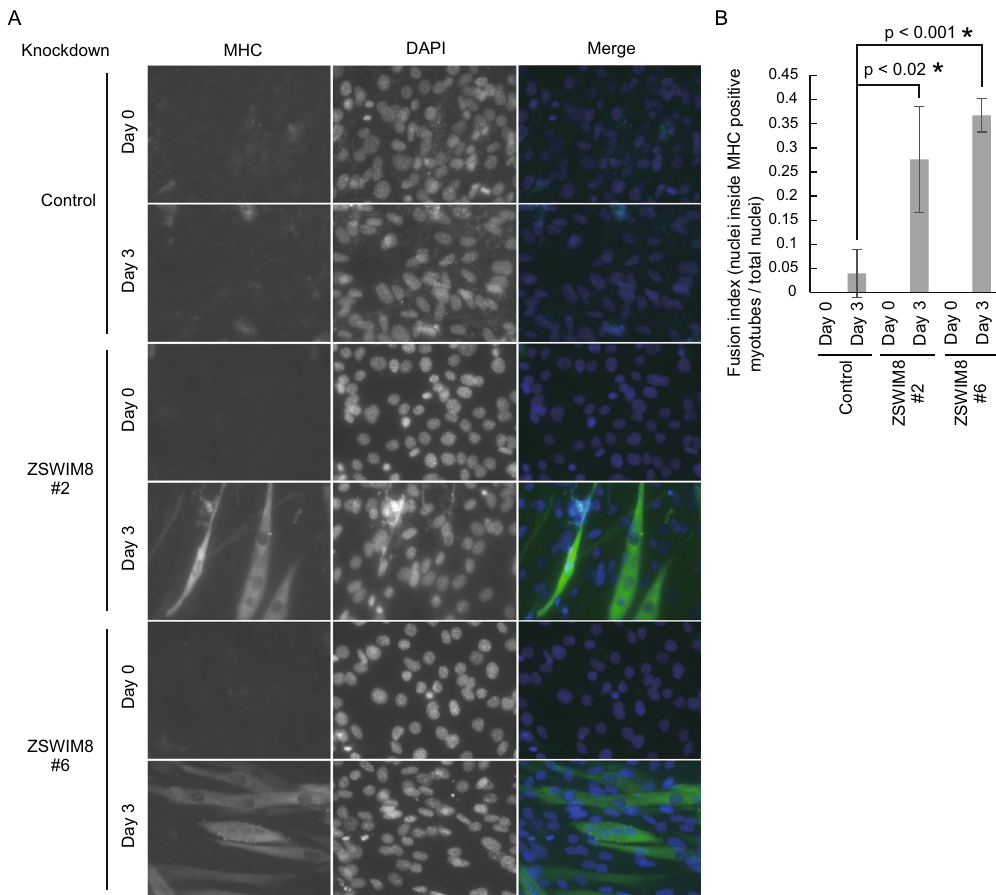
Figure 2. Accelerated myotube formation with ZSWIM8 knockdown. ( A ) Growing (day 0) or differentiated (day 3) control or ZSWIM8-knockdown (#2 or #6) C2C12 cells were immunostained with an anti-myosin heavy chain (MHC) antibody. Nuclei were stained with DAPI. Scale bar, 20 μm. MHC-positive and multinucleated cells were considered myotubes. ( B ) Quantification of fusion indexes of ( A ). The number of nuclei inside MHC- positive myotubes was divided by total nuclei in different fields. Data represent the mean ± SD; n = 150. Asterisk indicates statistical significance compared to the control